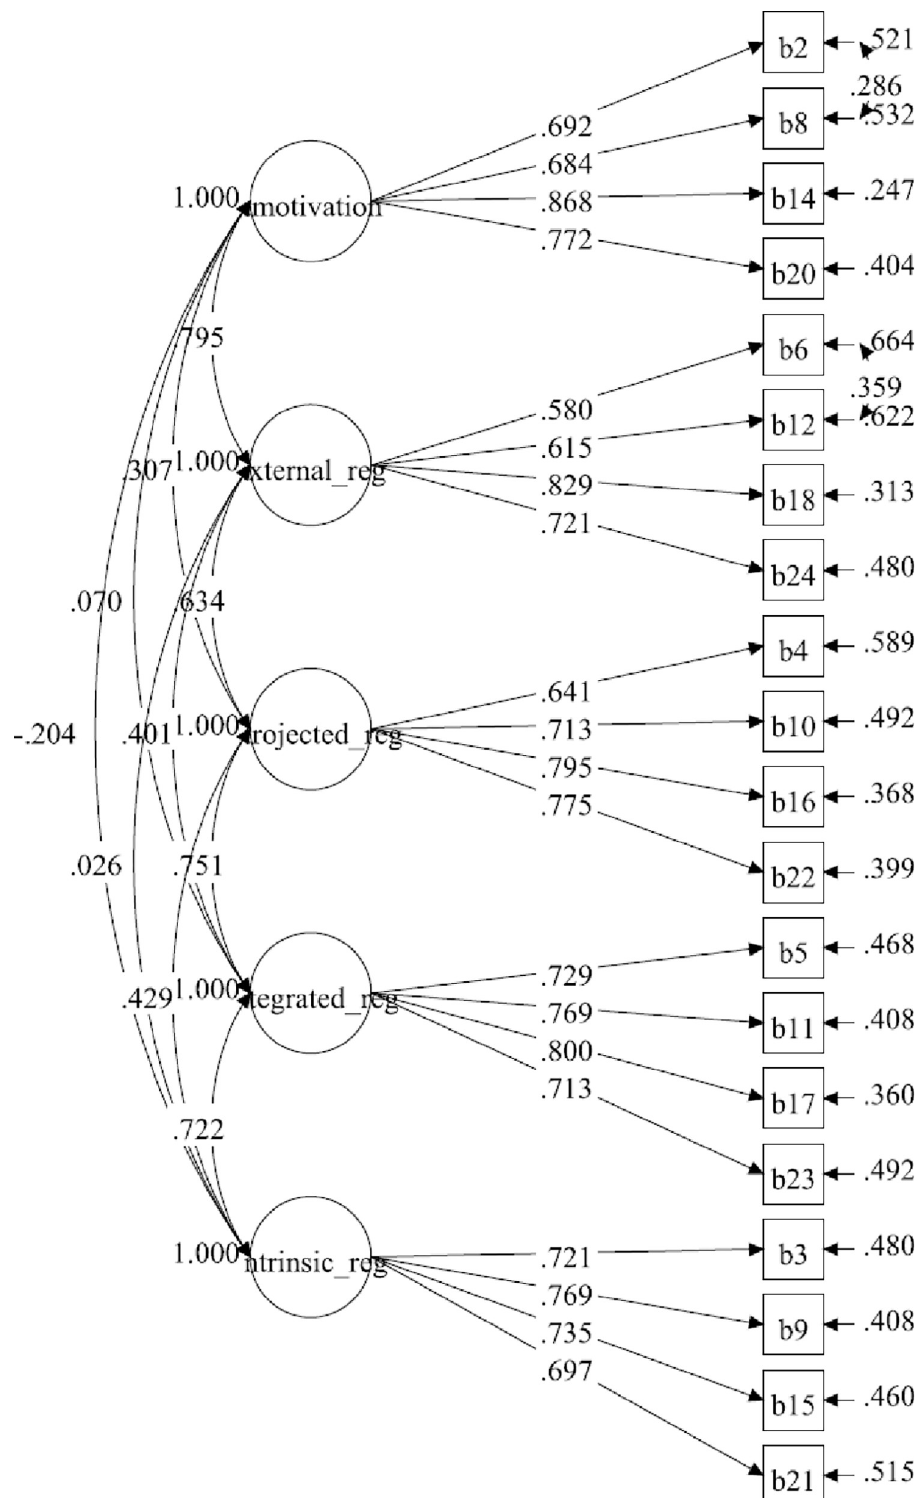
Fig 3. BREQ-3M measurement model (five-factor